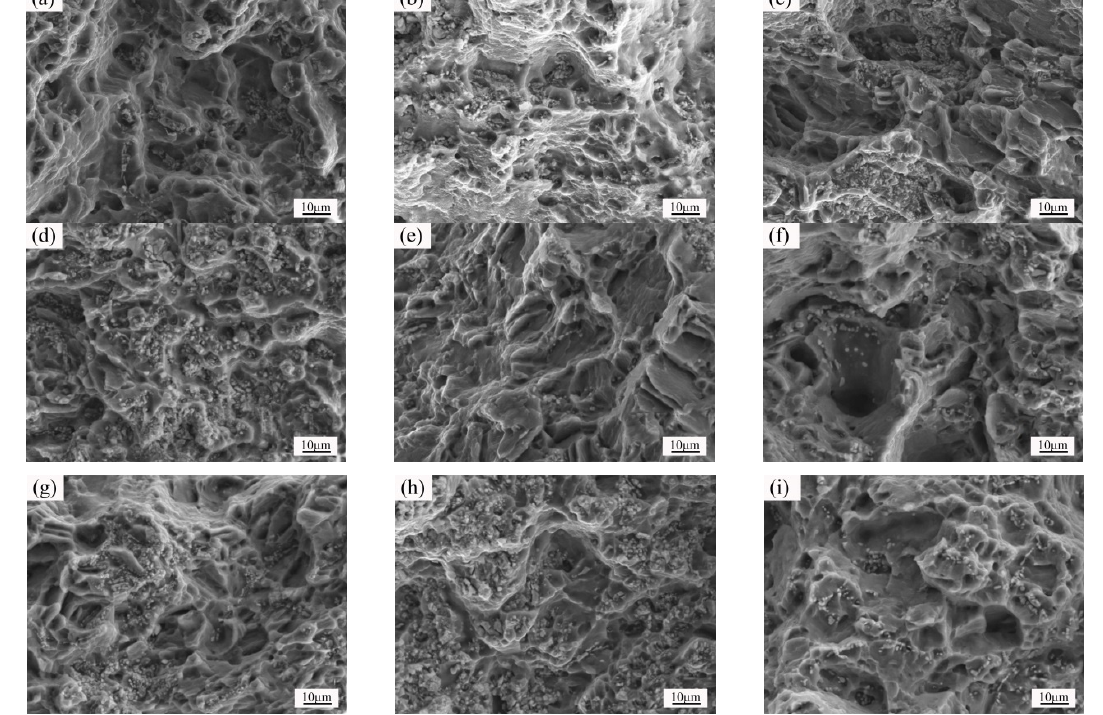
Figure 17. Fracture morphology of isothermal forging parts after post heat treatments: ( a ) 440 °C—1 h,